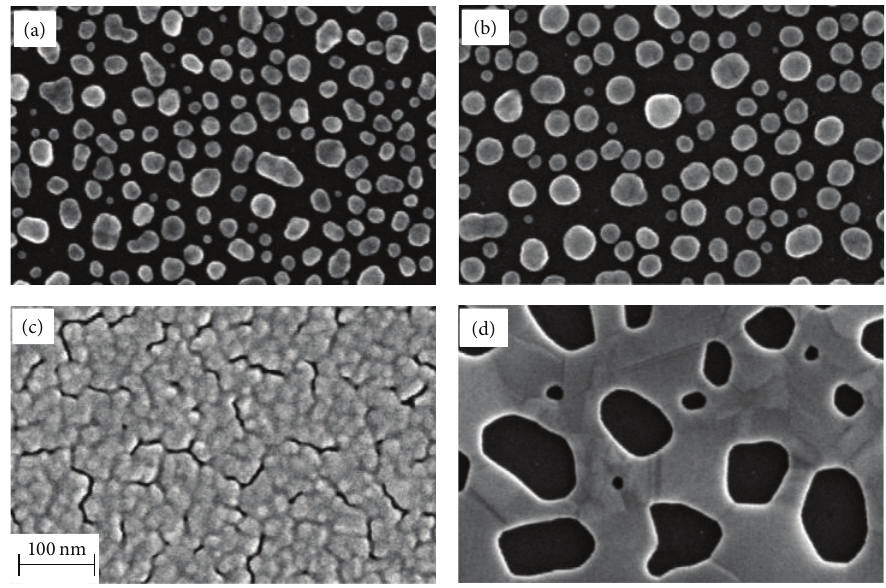
Figure 4: SEM images of thin layers of Ag (cases (a) and (b)) and Au ((c) and (d)) before ((a) and (c)) and after ((b) and (d)) annealing at 400 ∘ C. The thicknesses of Ag and Au layers are 5 and 15nm, respectively.